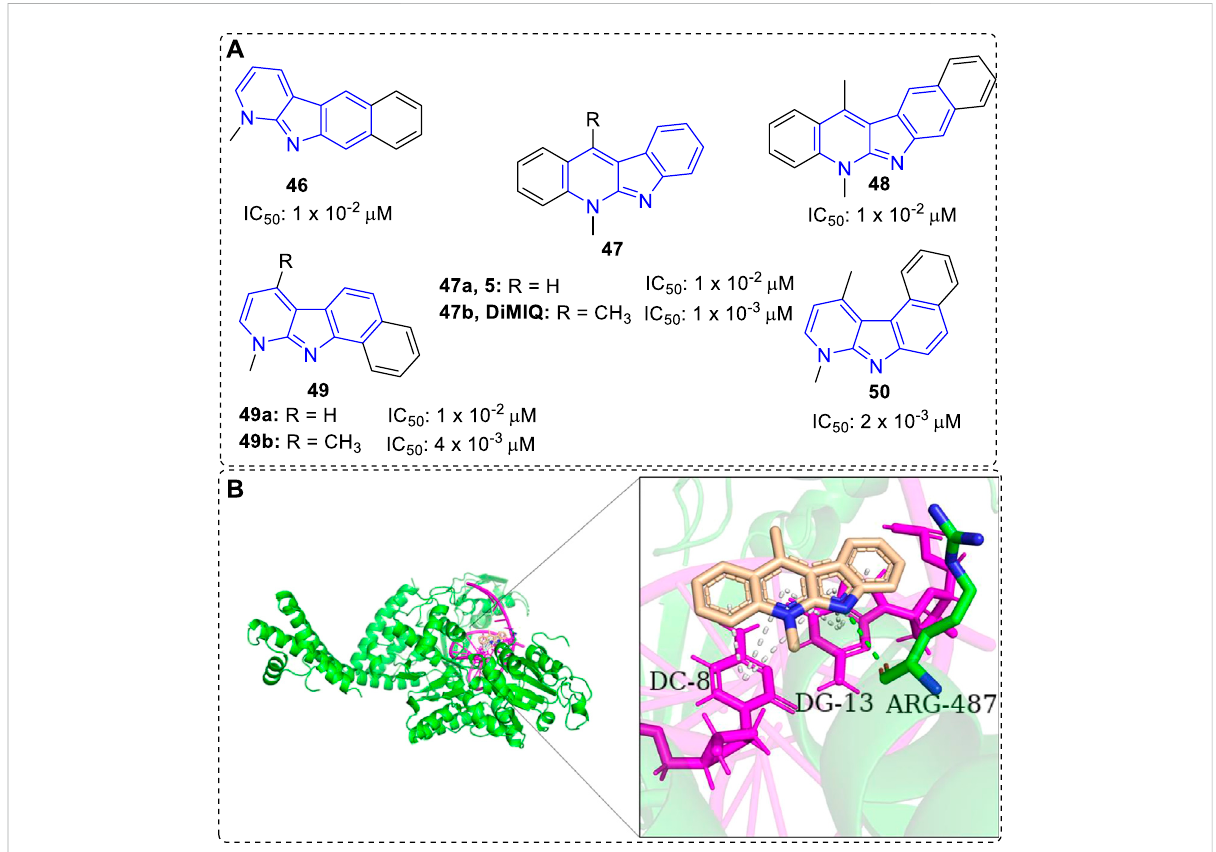
FIGURE 4 (A) Structures and bioactivity of compounds 46 – 50 with various shapes and sizes. IC 50 values were tested in vitro against KB cells. (B) DiMIQ ( 47b )intheactivesiteofTopII α complexedwithDNA(PDBcode:5GWK). 47b isrepresentedinstickmodel,carbonsin 47b arecoloredwheat,DNAis colored magenta, ARG-487 residue of Top II α is colored green and labeled. Hydrogen bond is presented as green dash line. π - π interactions are presented as white dash